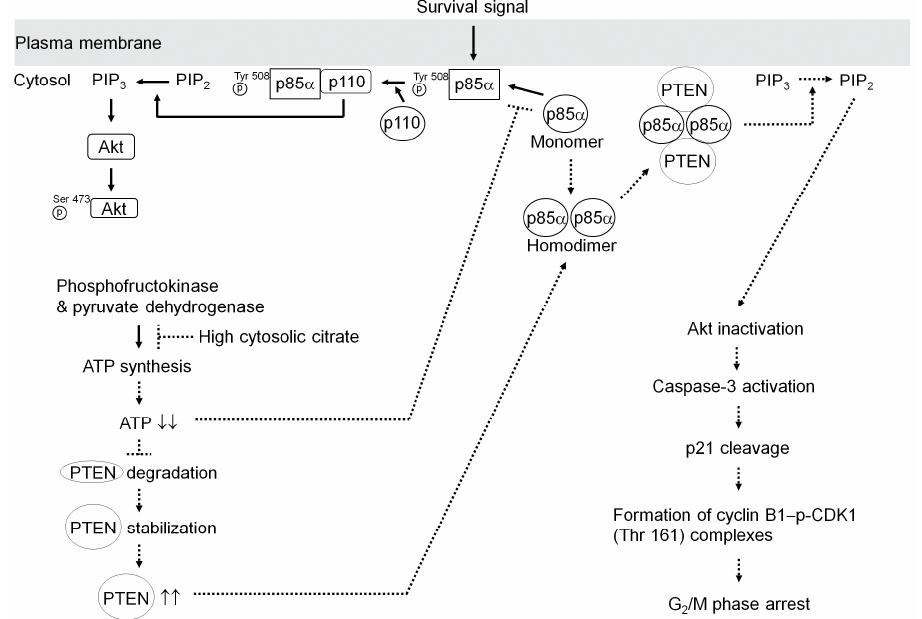
Figure 7. A molecular model for the induction of G 2 / M phase arrest in human PSC cells by citrate.